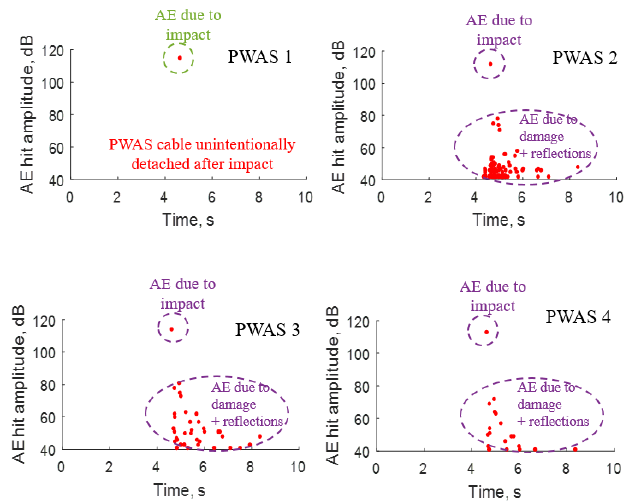
Figure 11. AE hits observed at the four PWAS due to 16 J impact event.